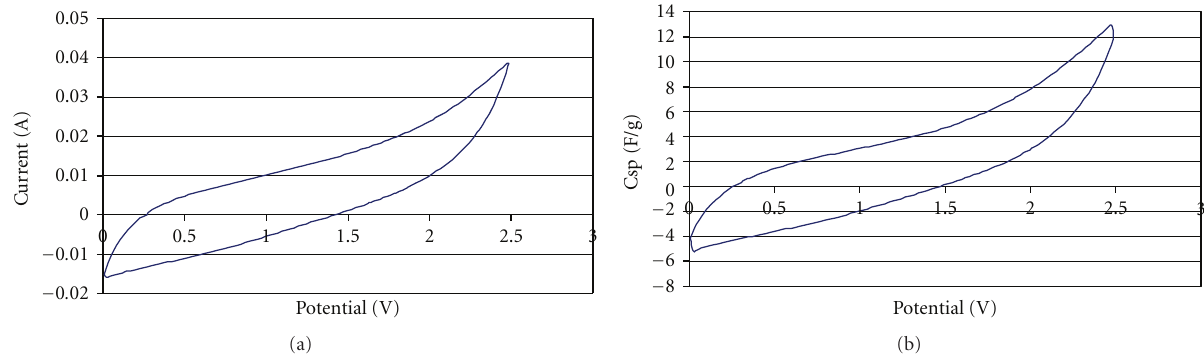
Figure 2: Cyclic voltametry of EDLC CWF-GF/F capacitor from 0 to 2.5V at a rate of 0.15V/s and specific capacitance of electrode; each carbon electrode has an area of 2 cm 2 and mass of 40mg.